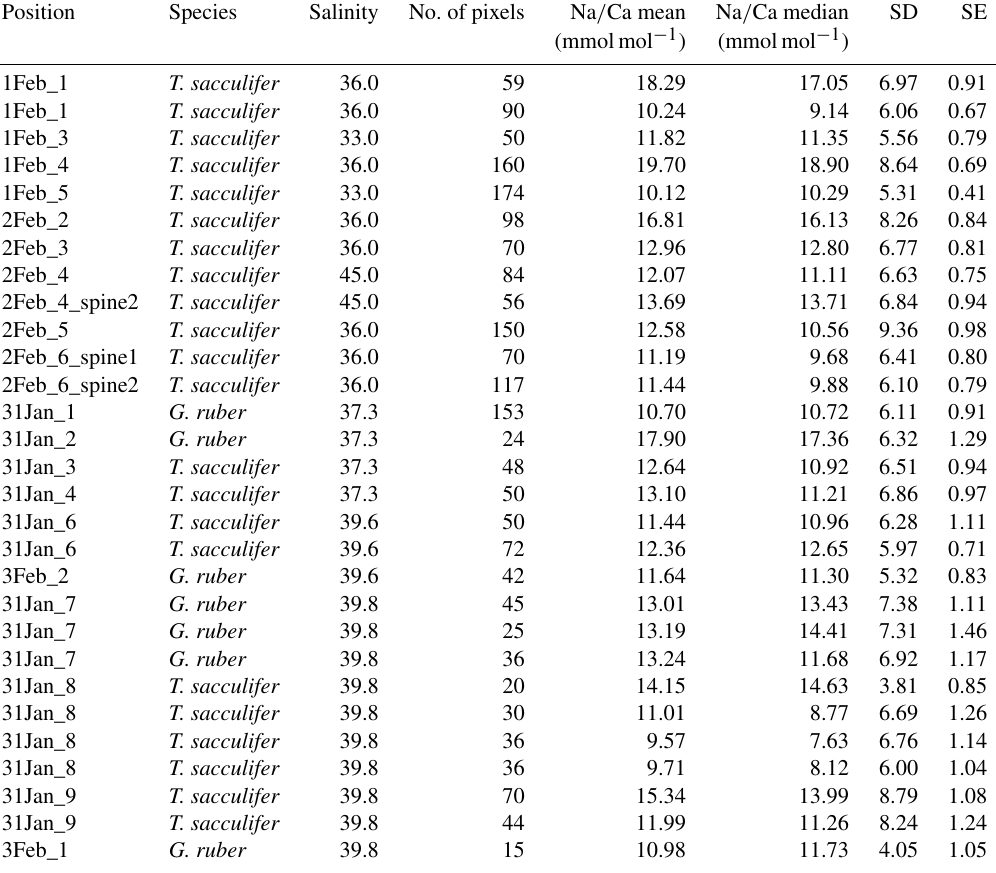
Table 6. Overview spine base measurements of cultured and field-collected specimens (Table 1).